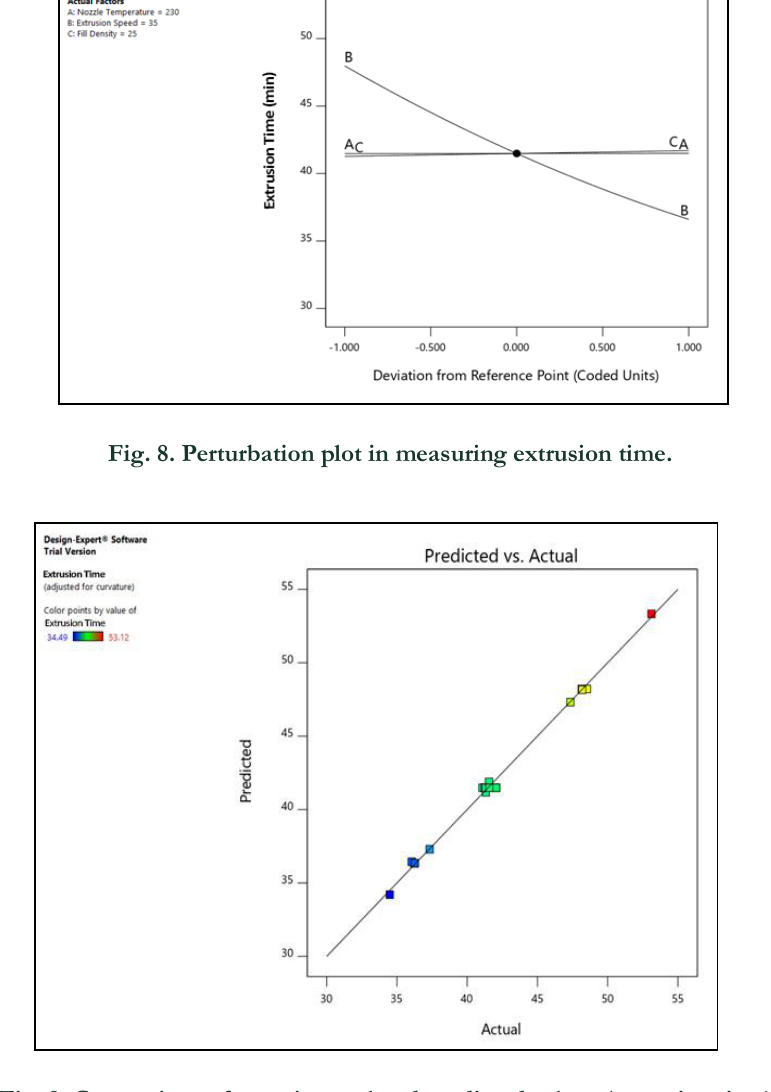
Fig. 9. Comparison of experimental and predicted values (extrusion